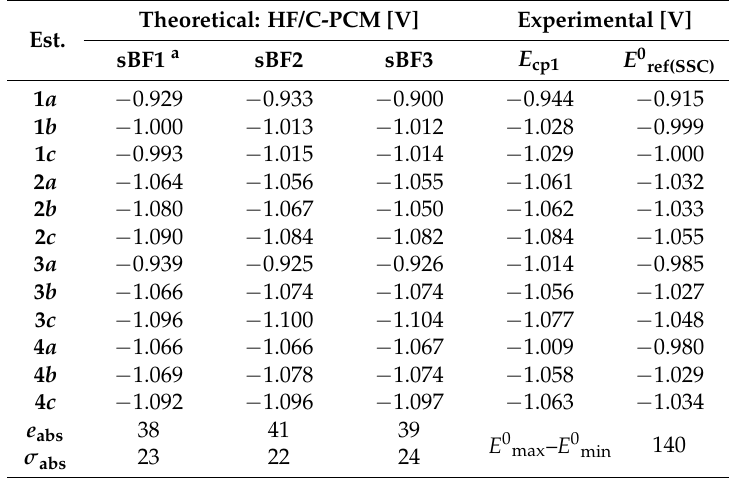
Table 2. Theoretical reduction potentials calculated at HF level with C-PCM continuum solvation model of 12 investigated nitroaromatic MBHA. Reduction potentials values are in volts. Mean absolute errors ( e abs ), standard deviation of absolute errors ( σ abs ), and range of experimental values ( E 0 max – E 0 min ) are in millivolts.